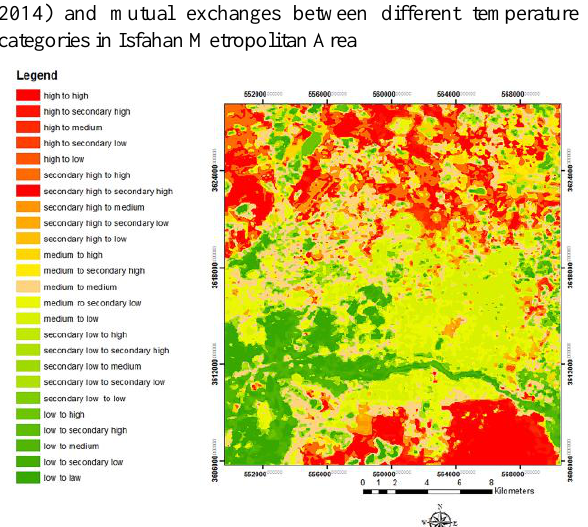
Fig. 5 Cross-tabulated land surface temperature layers (1998- 2014) and mutual exchanges between different temperature